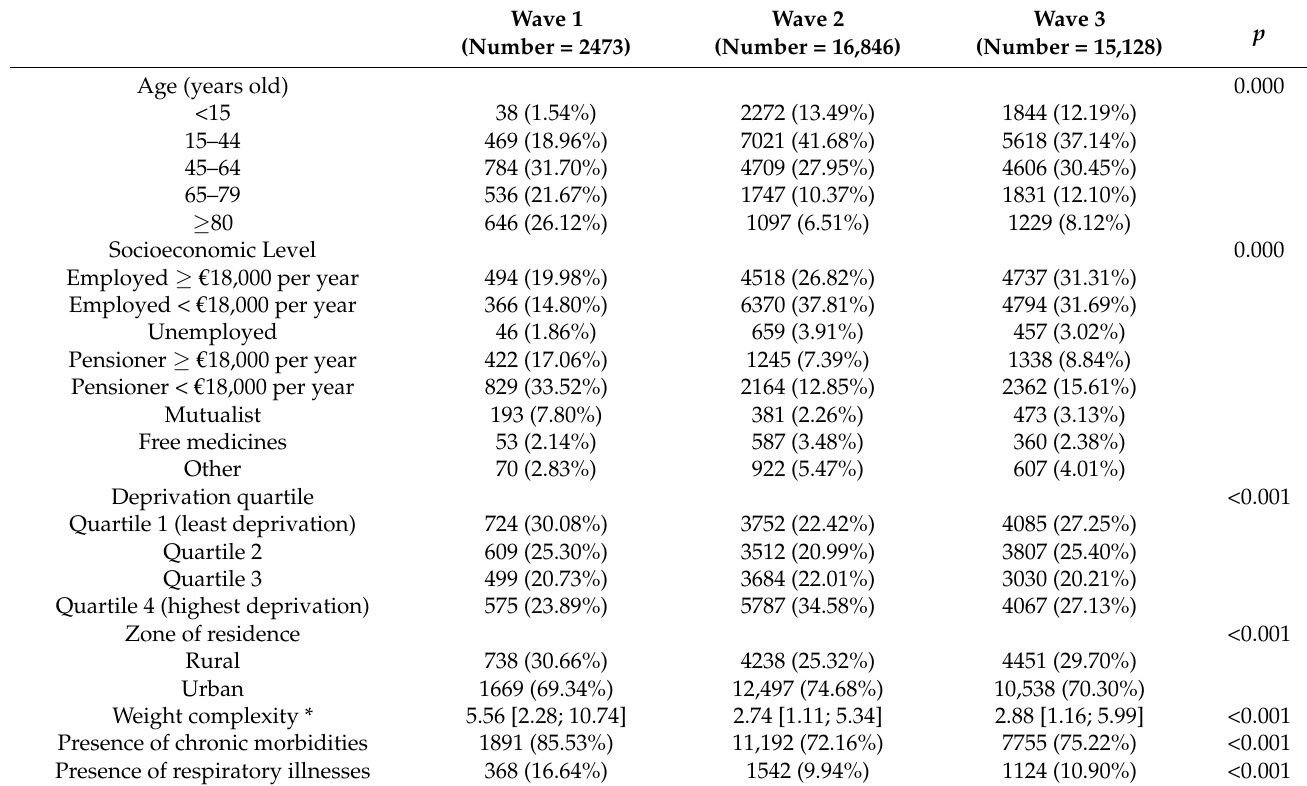
Table 2. Sociodemographic and morbidity description of confirmed COVID-19 men. Differences by